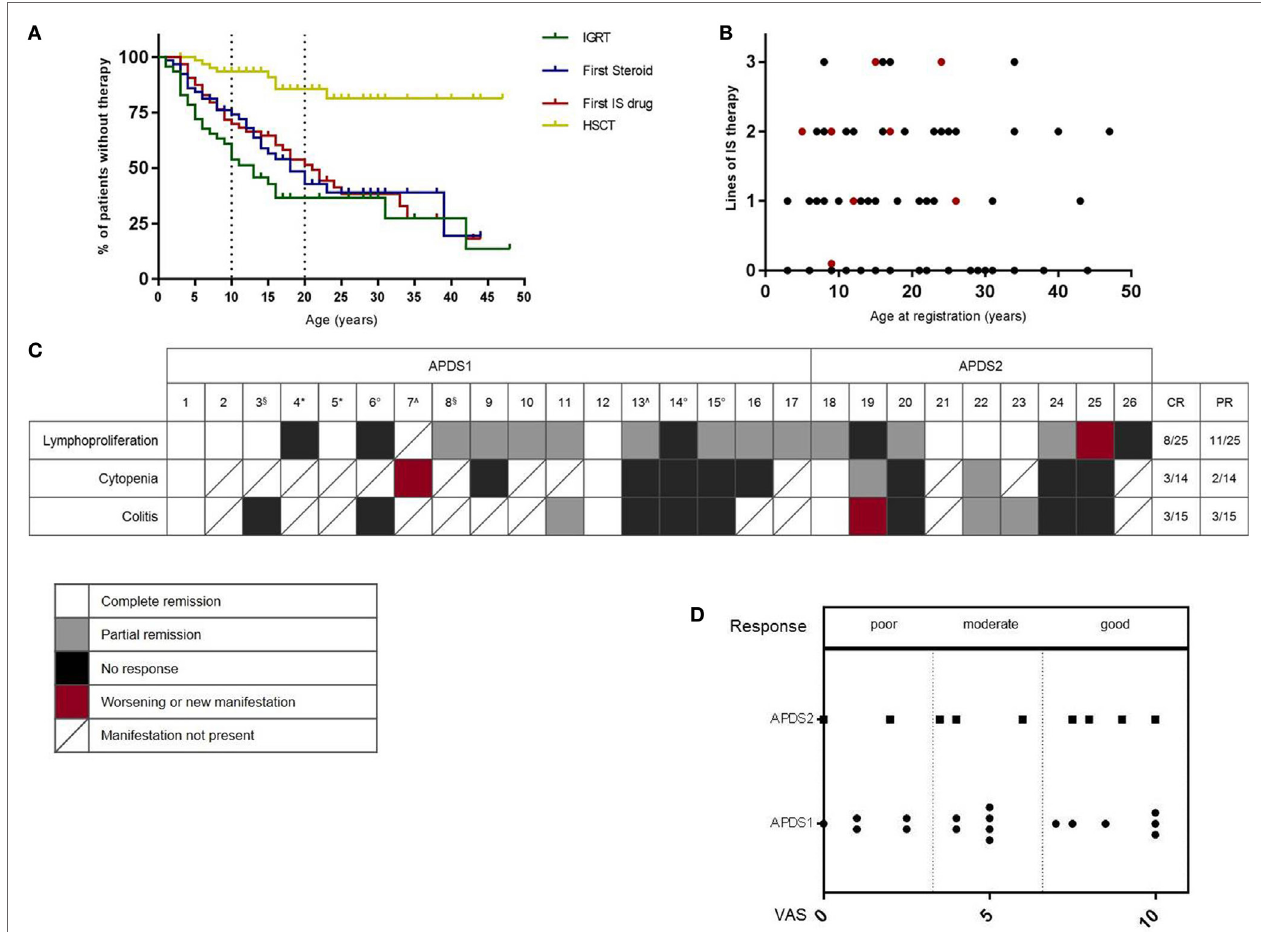
FiGUre 2 | (A) Use of treatment modalities over time. IGRT, immunoglobulin-replacement-treatment; IS, immunosuppressive drug; HSCT, hematopoietic stem cell transplantation. Information regarding age at first therapy available for: IGRT n = 28/44, steroid therapy n = 31/31, IS therapy n = 35/36, HSCT = 8/8. (B) Number of lines of immunosuppressive treatments (steroids, immunosuppressive drugs, rituximab) by the time of registration; red: patients who had undergone HSCT by the time of registration. (c) Response to rapamycin treatment. White : complete response; gray : partial response; black : no response; red : worsened or new manifestation; boxes with a diagonal : manifestation not present in this patient. CR, complete remission; PR, partial remission. Rapamycin stopped because of: *non-compliance, °inefficiency, ^side effects, § clinical trial. (D) Overall clinical benefit (Visual Analog Scale) according to physician’s